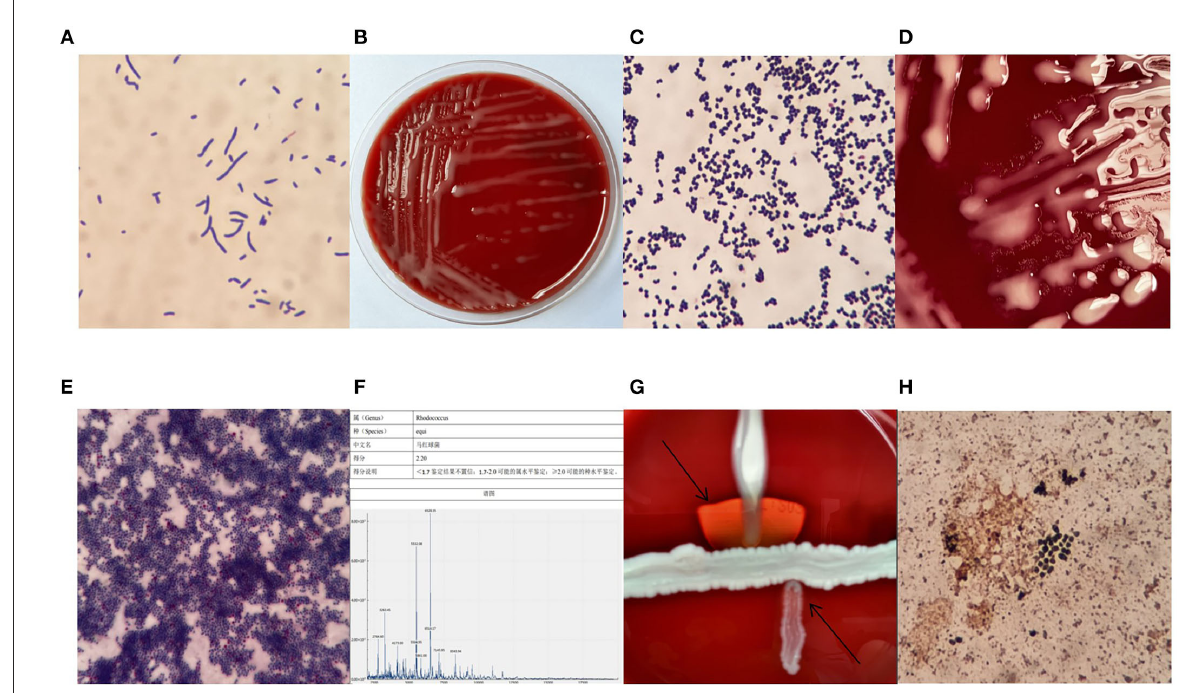
FIGURE2 Gram stain after 6h of pure culture (A) × 1,000, colony morphology after 24h of pure culture (B) , Gram-stained morphology after 24h of pure culture (C) × 1,000, fungal pseudomycorrhizal-like material (D) , the morphology of weak acid-fast stain (E) × 1,000, mass spectrometer